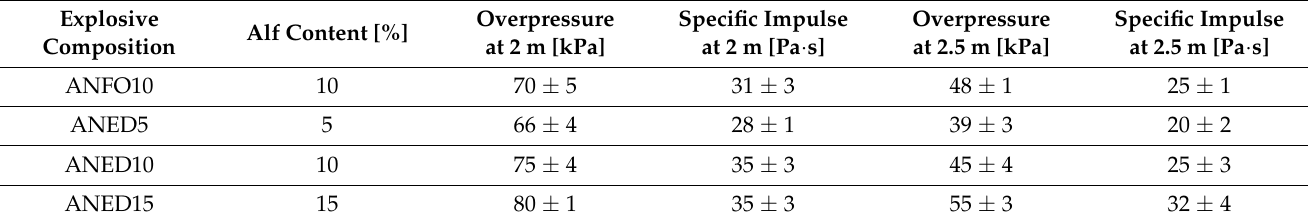
Table 9. Blast waves characteristics for ANFO and AN/ ethan-1,2-diol mixtures with an addition of Al f .